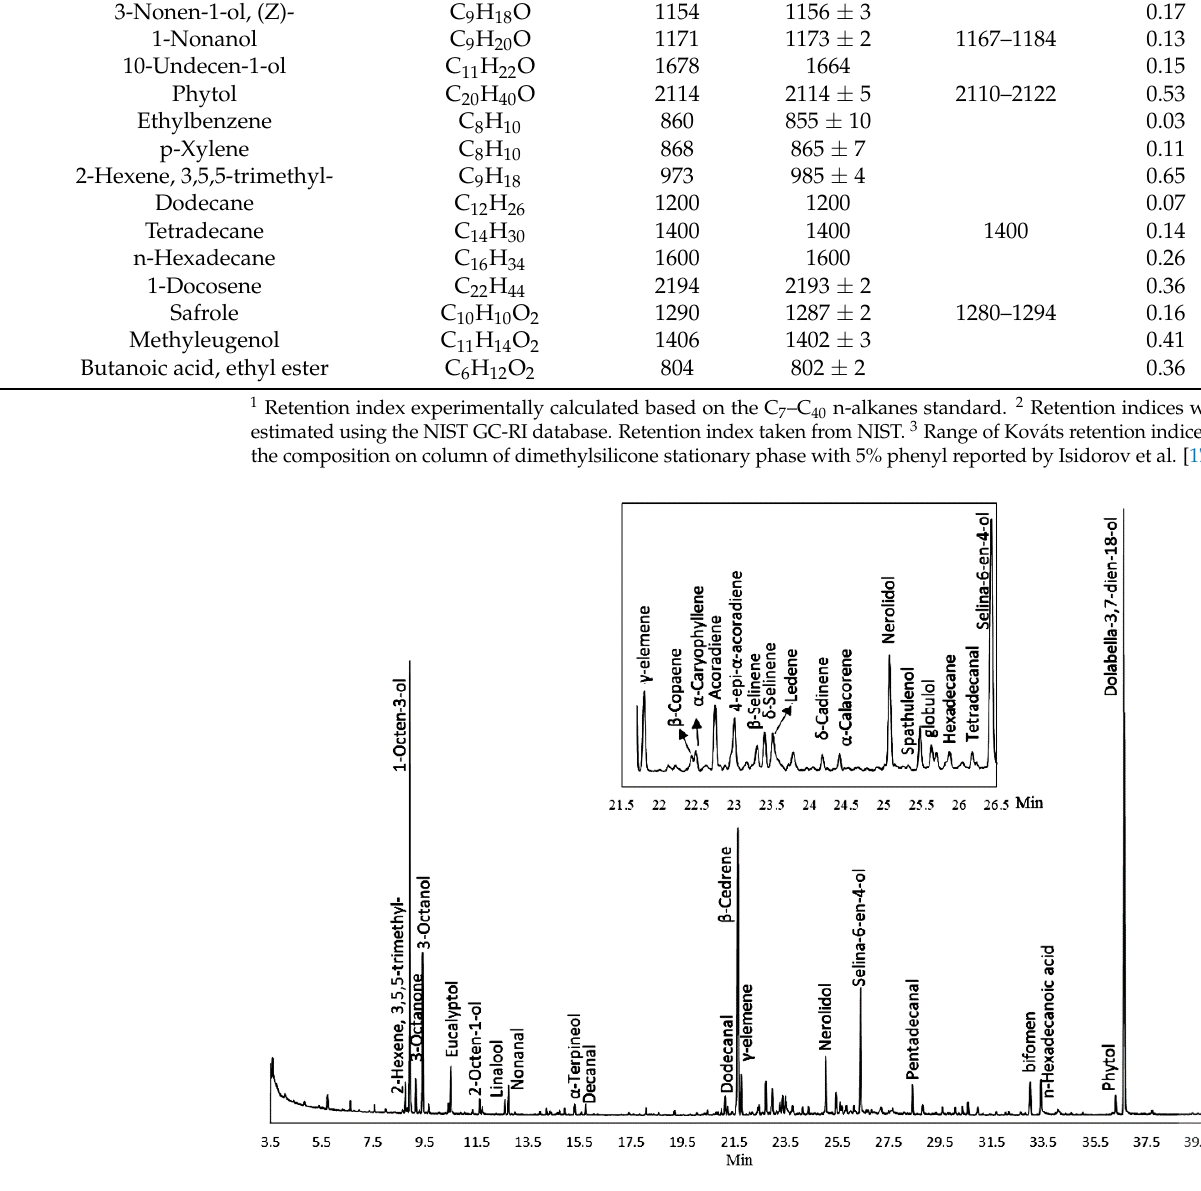
Figure 1. Gas chromatogram mass spectrometry of P . acutum oil.